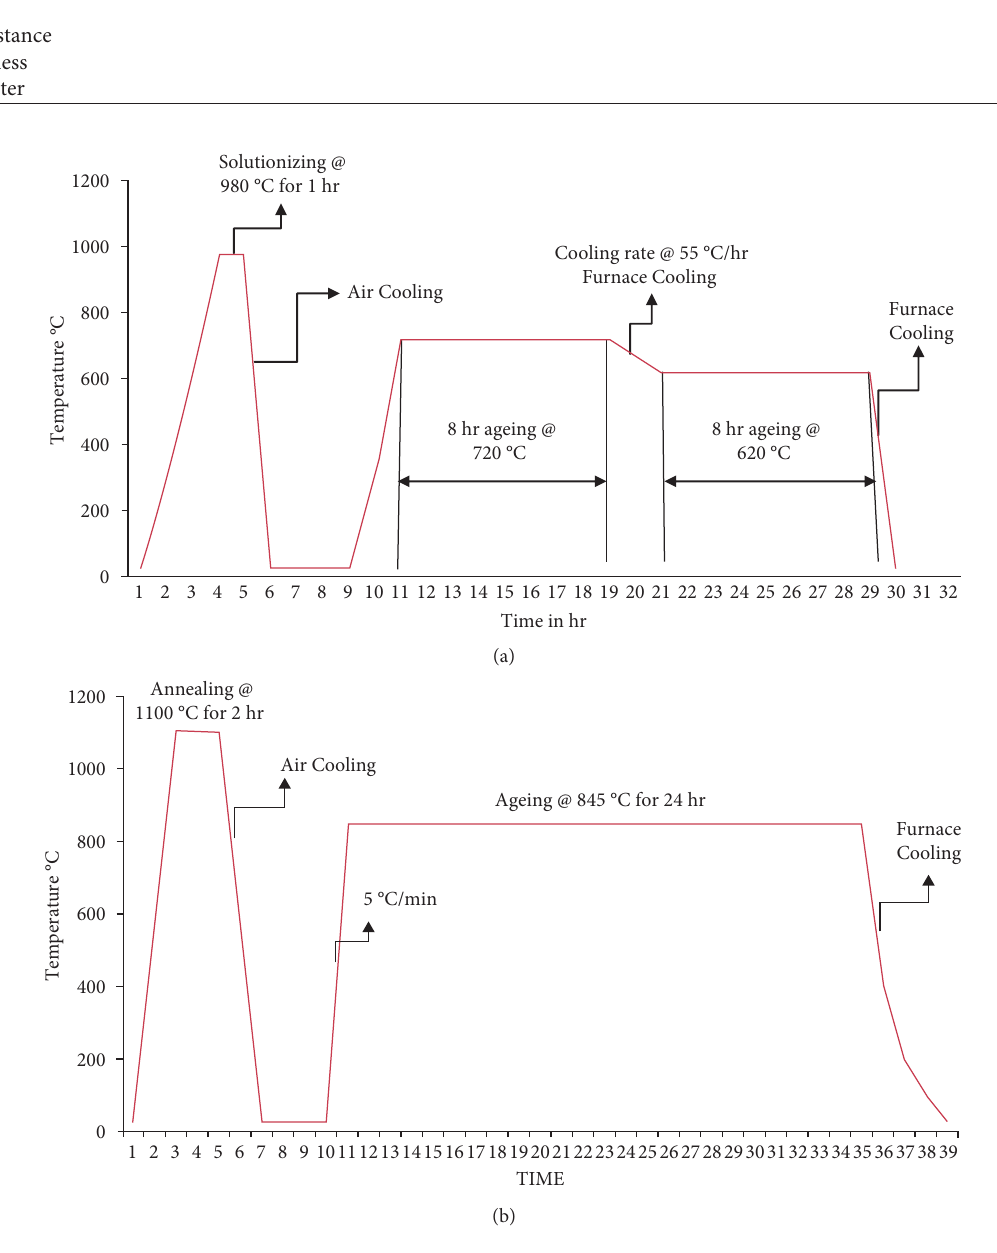
Figure 1: Heat treatment cycles for DMLS processed material: (a) HT 1 and (b) HT 2. Table 3: Heat treatment